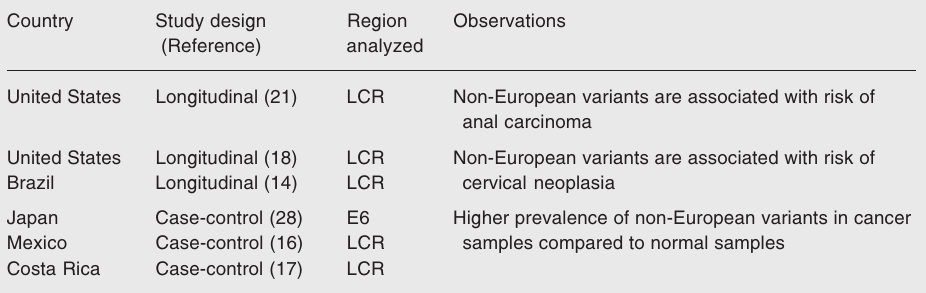
Table 1. Epidemiologic associations between non-European variants of human papillomavirus-16 and in- creased risk for cervical neoplasia.